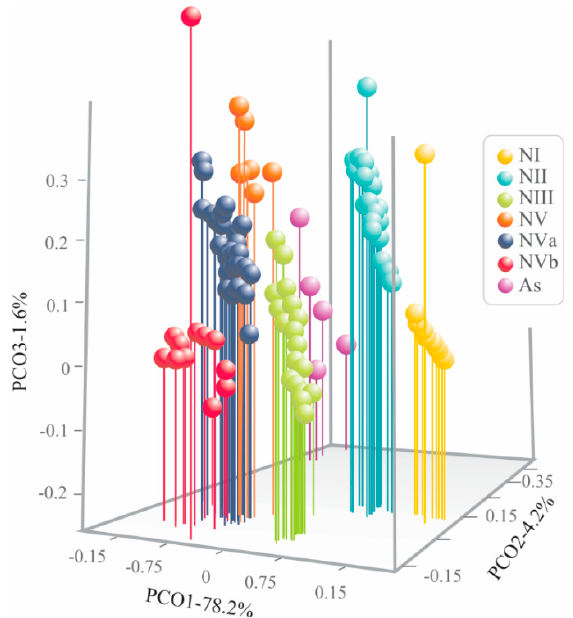
Figure 5. Scatter plot from principal coordinate analysis of morphological characteristics of both nymphal and adult specimens of Ocoaxo assimilis using 15 continuous, plus four discrete, characteristics. Adults (As) and nymphal stages one to five (NI, NII, NIII, NIV, NVa, and NVb).